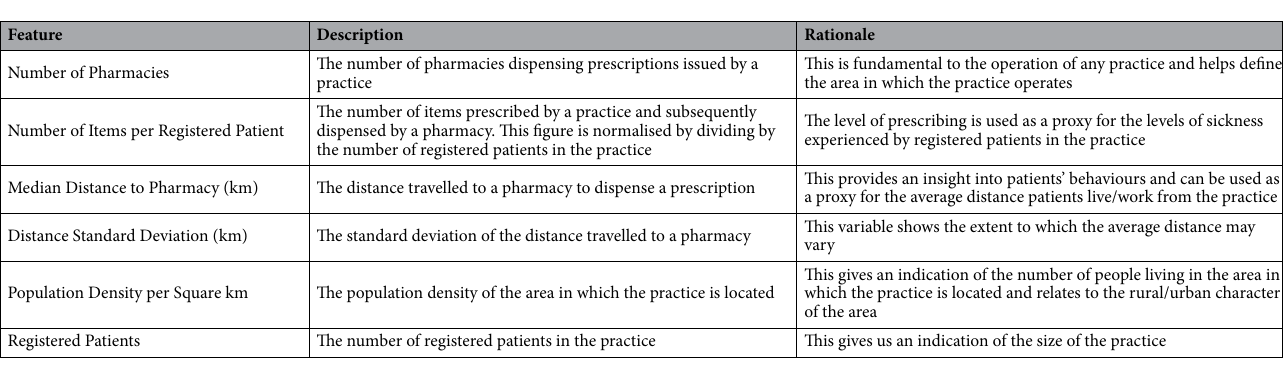
Table 1. Summary of Features used for